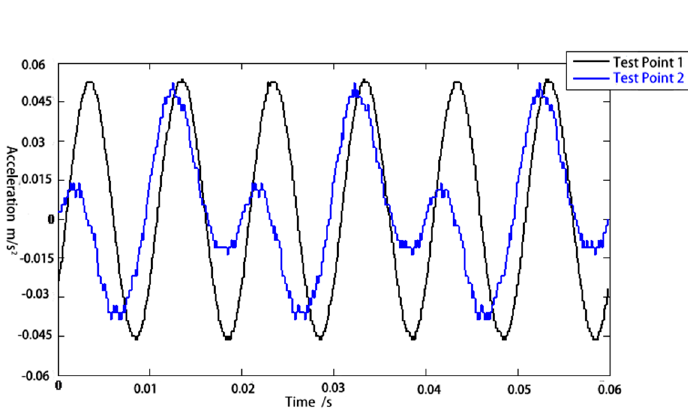
Figure 2. ( a ) Position of vibration-acceleration sensor; ( b ) field experiment.